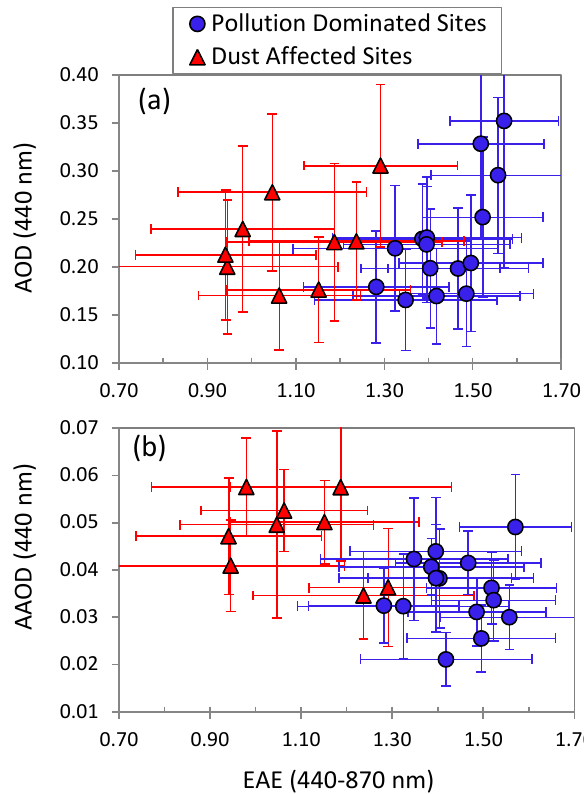
Figure 3. Average AERONET level 2 (entire data sets) scatter plots between (a) AOD vs. EAE and (b) AAOD vs. EAE for the 24 se- lected sites in and around the Mediterranean basin. The red trian- gles represent dust affected sites and blue circles show pollution dominated sites. The error bars represent ± σ /2, where σ is stan- dard deviation of AERONET level 2 (entire) data sets for respective